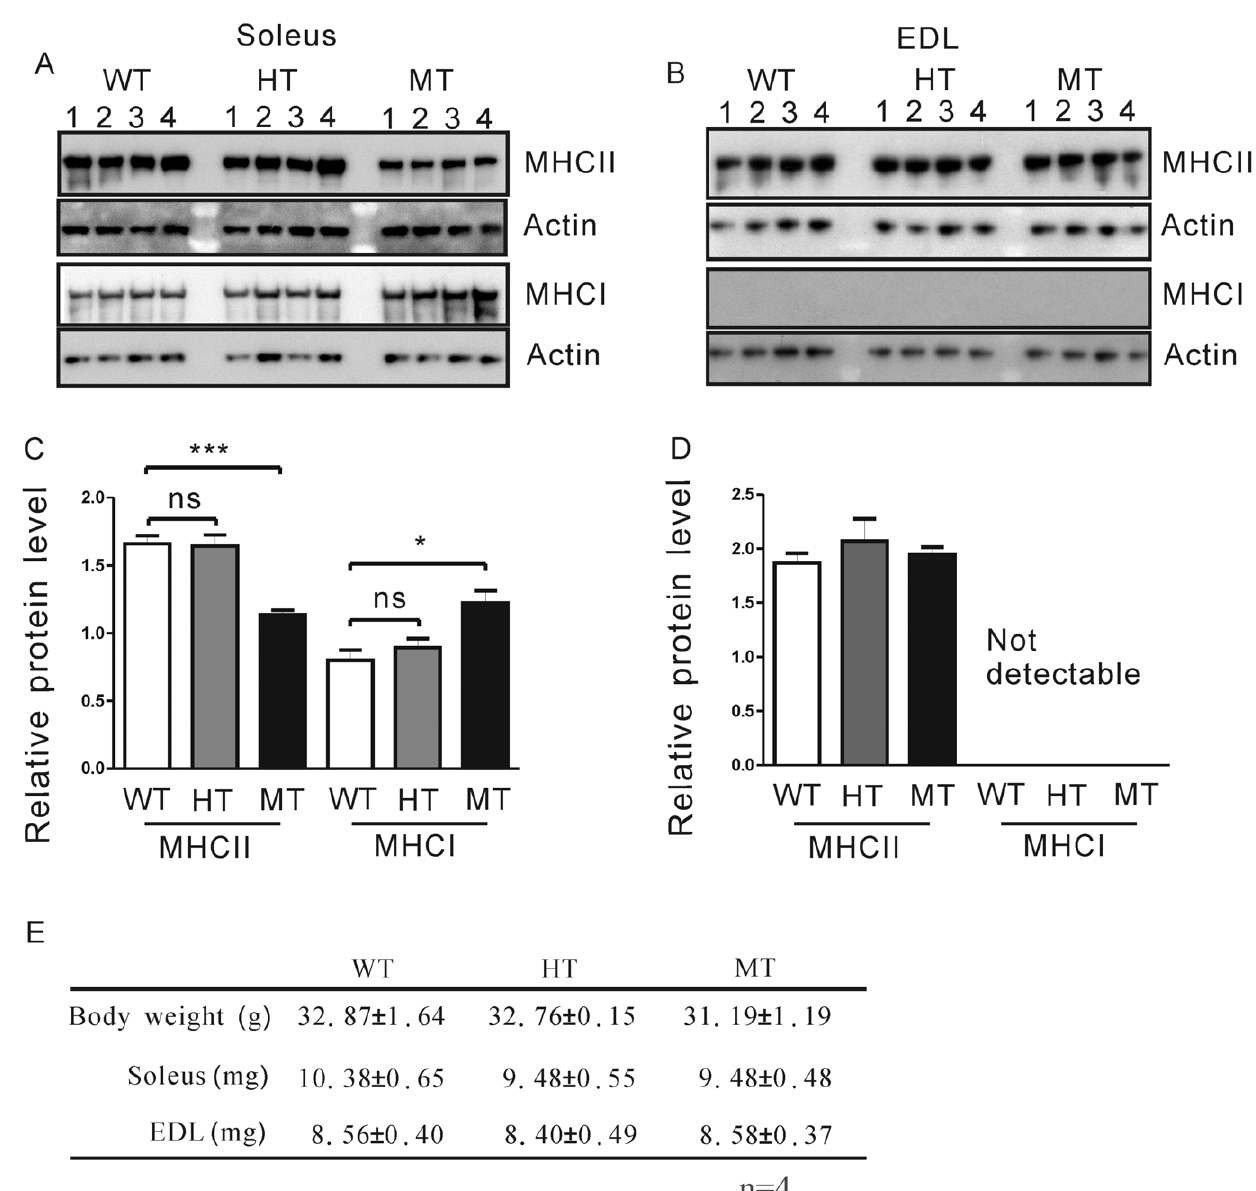
Figure 7. Expression of MHC II decreased in old Gas7-deficient soleus while MHC I expression increased. Myofiber subtypes in the soleus or EDL of the 12 months old wild-type and Gas7-deficient mice were determined by anti-MHC I (slow muscle fiber) and anti-MHC II (fast muscle fiber) subtype-specific antibodies. (A) Levels of MHC II expression in soleus from Gas7-deficient (MT) mice were lower than wild-type (WT) and heterozygous (HT) groups (n =4). (B) In EDL, no significant difference between Gas7 wild-type (WT), heterozygous (HT), and deficient (MT) mice was observed. Protein extract (2 m g), separated by NuPAGE on 3–8% gels (Invitrogen), was transferred to PVDF membranes and probed with specific antibody for MHC I (NOQ7.5.4D, Sigma) and MHC II (My32 antibody, Sigma). Internal control lanes were probed with anti-actin antibody (Chemicon) on the same membrane. (C) and (D) show histograms based on densitometry of the Western blot signals shown in (A) and (B). Levels of both types of MHC were normalized to actin (internal control) in soleus and EDL. Mean 6 SEM, *** P , 0.001, * P , 0.05. (E) Body weight and weight of soleus and EDL muscle of Gas7 wild-type (WT), heterozygous (HT) and deficient (MT) mice.